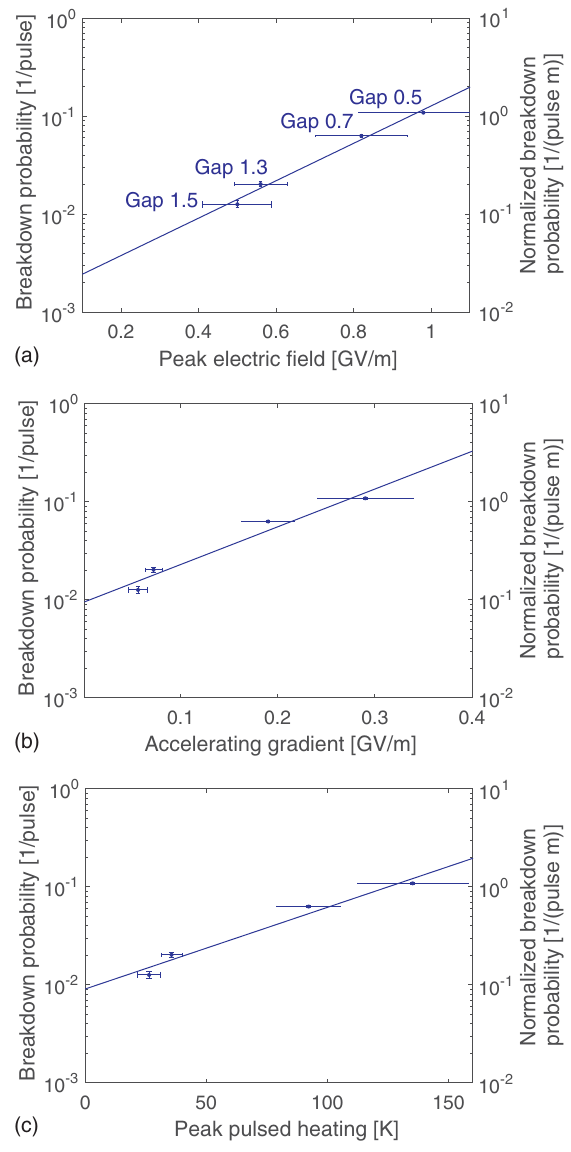
FIG. 19. Constant gradient breakdown rate measurements, obtained by placing the electron beam in the central axis of the copper structure, with 3.2 nC of bunch charge and σ ¼ 50 μ m, as a function of the peak electric field (a), as a z function of the accelerating gradient (b), and as a function of the peak pulsed heating (c). The repetition rate varied from 1 to 15 Hz. a threshold. The spikes with larger values than this threshold (in absolute value) are tagged as breakdowns. Figure 18(b) is the histogram of the distribution of the current monitor voltages. In the histogram representation, breakdowns are recognized when the histogram bars lie outside the red threshold lines. These breakdown rate measurements have been performed at different gaps. ¼ 50 μ m. They are shown in Fig. 19, for the copper experiment z